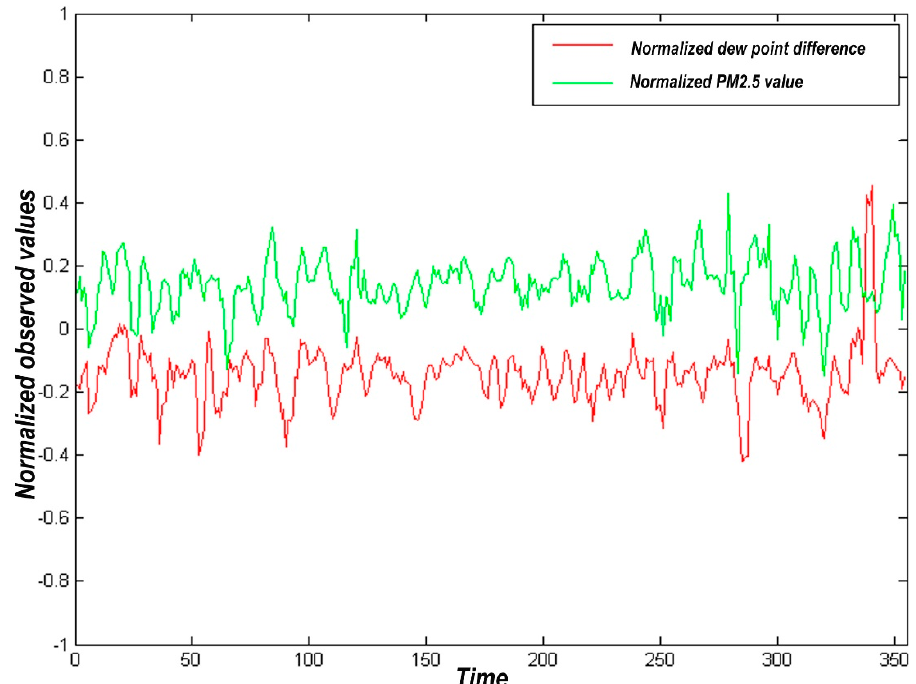
Figure 2. Correlation between dew point difference and PM2.5 difference.